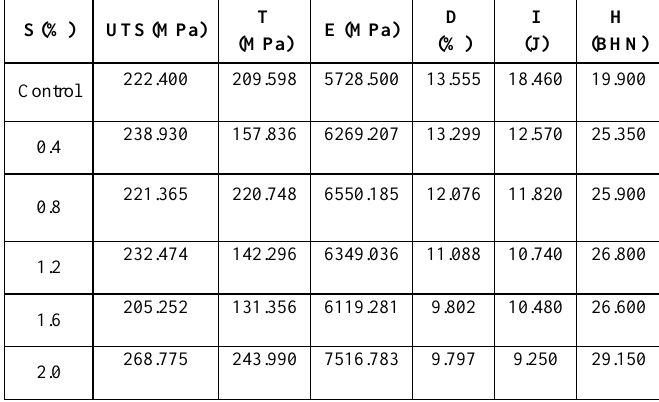
Table 3: Mechanical Properties of Nano-Particulate Graphite Reinforced Brass